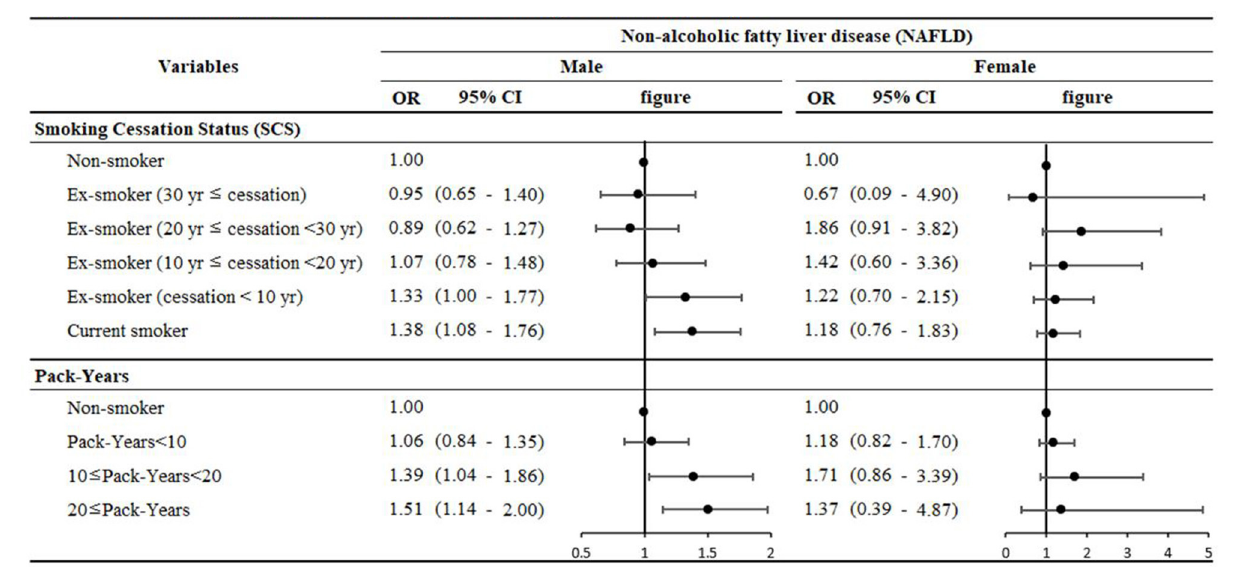
FIGURE2 Results of the subgroup analysis stratified by smoking cessation and